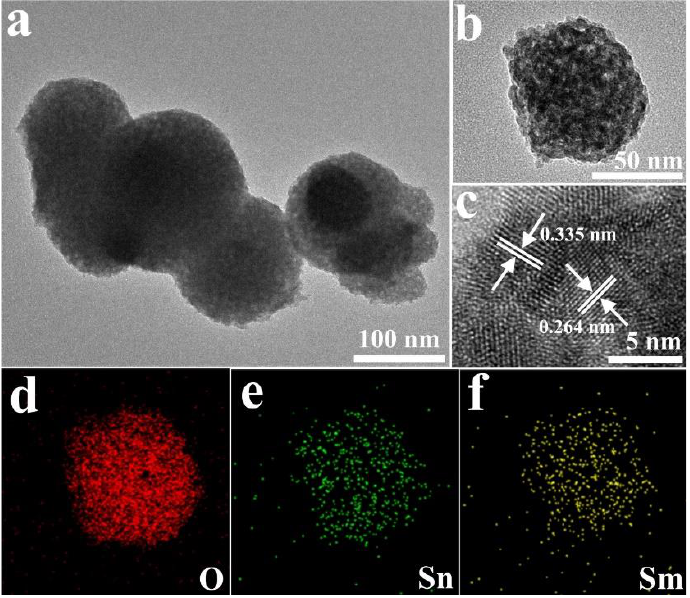
Figure 7. ( a and b ) TEM images and ( c ) HRTEM image of 2.5 mol% Sm 2 O 3 -doped SnO 2 . ( d – f ) The Result of corresponding elemental mapping analysis [121]. Reprint permission was obtained from Elsevier.